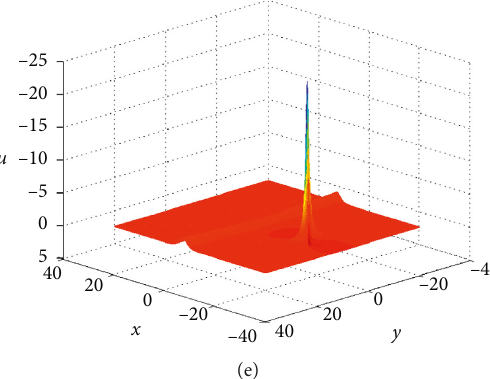
� 1 , α � 1 , α � 1 , α � 1 , α � 1 , α � 1 , ξ � 1 , and l � 1. 1 2 4 5 8 9 1